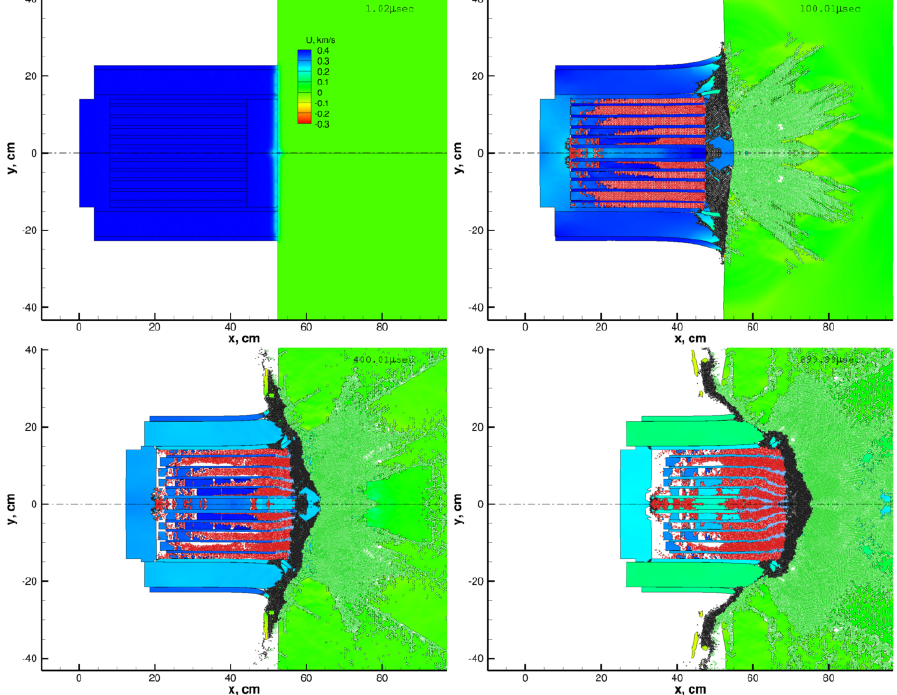
Figure 10: Impact of a reactor model with a sandstone plate